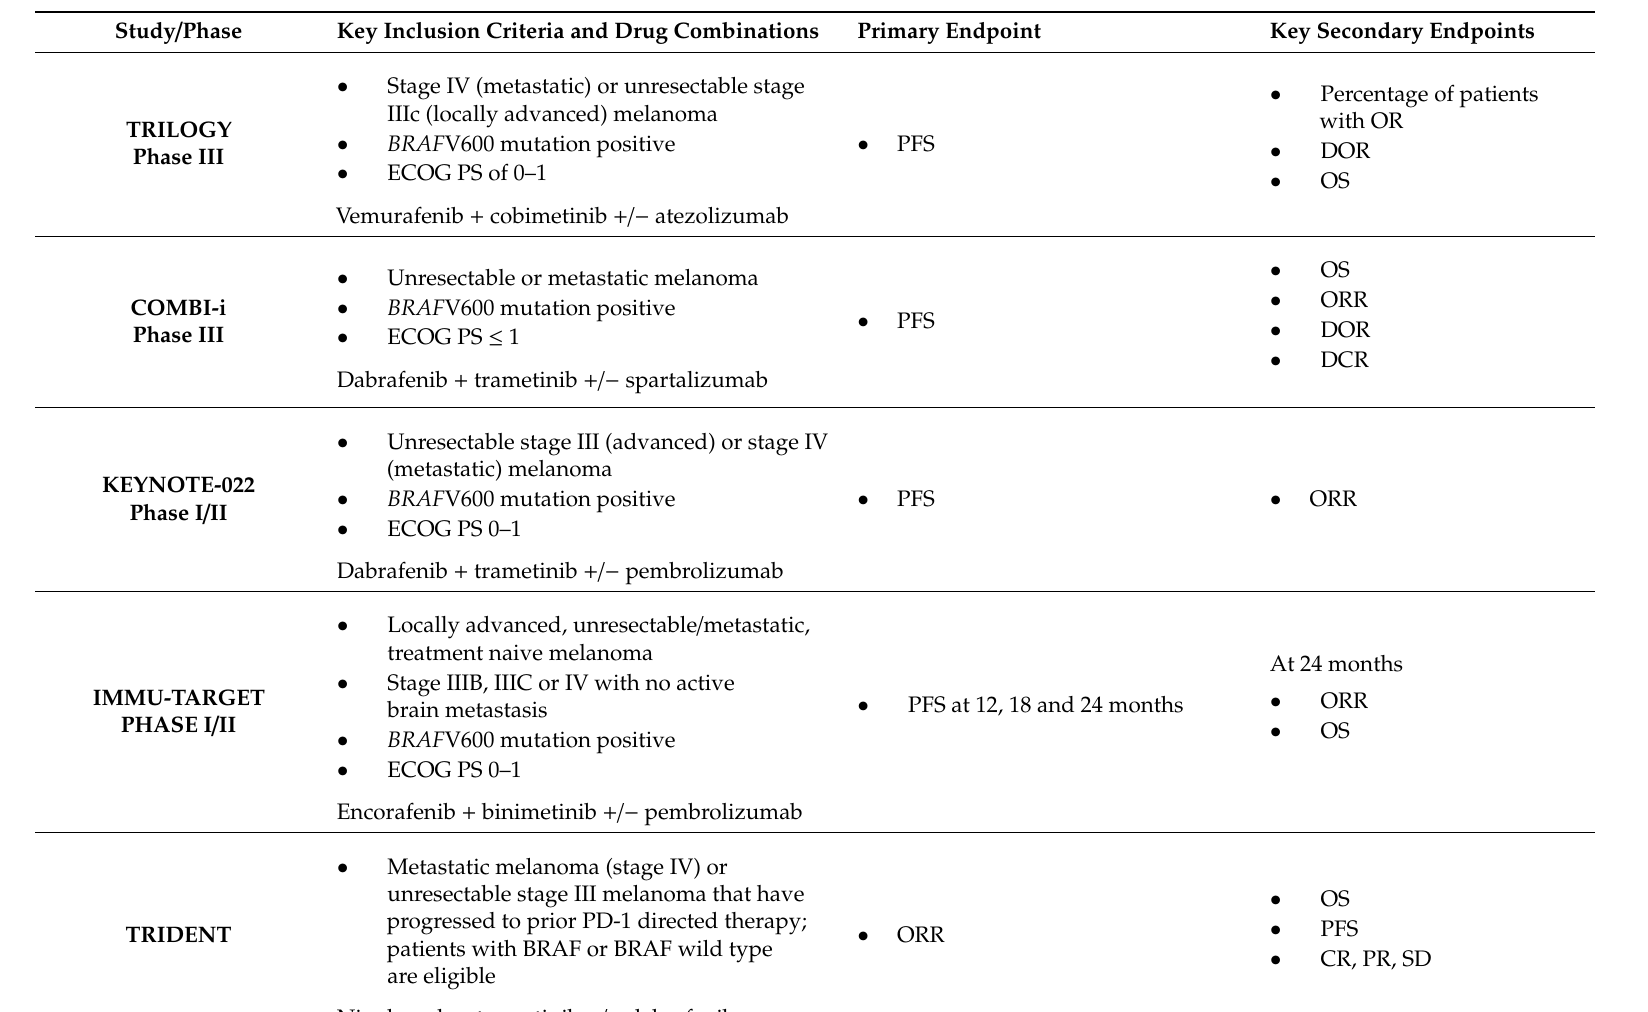
Table 1. The summary of the most important current clinical trials with targeted therapy and immune checkpoint inhibitors in combination